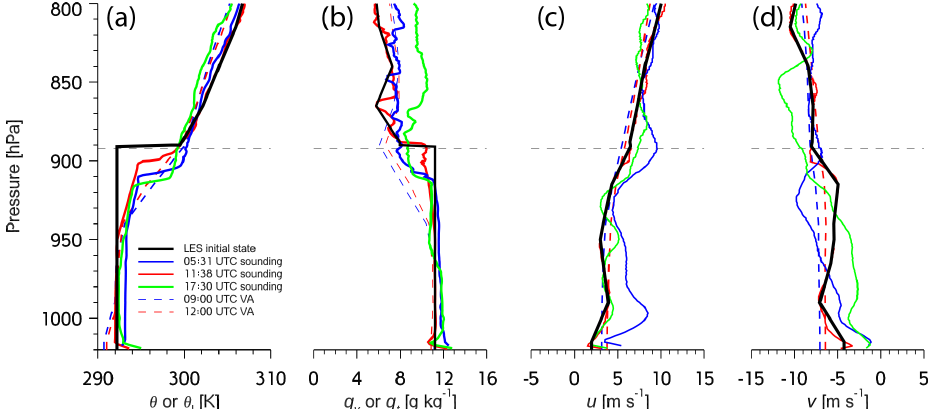
Figure 2. Vertical profiles of the 18 July 2017 boundary layer from radiosondes taken at Graciosa Island (05:81, 11:38, and 17:30UTC) and the ARM VARANAL product (09:00 and 12:00UTC), which itself assimilates the soundings. The figure panels show the following: (a) potential temperature or liquid water potential temperature (LES profile), (b) water vapor mixing ratio or total water mixing ratio (LES profile), (c) u , and (d) v . The solid black line represents the simplified LES initial condition profile constructed from the 11:38UTC sounding.